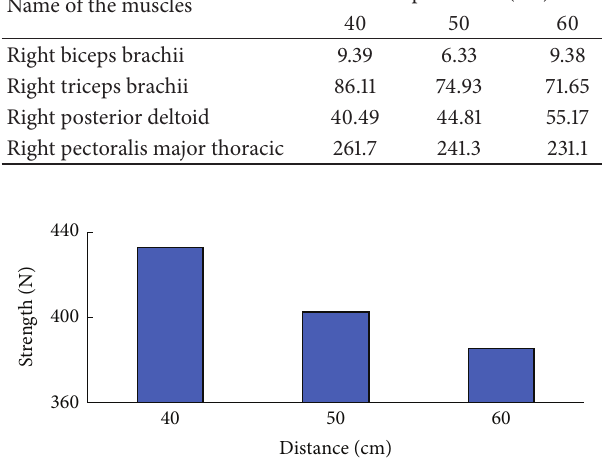
Figure 3: Analysis of the major pectoralis force using three grips.